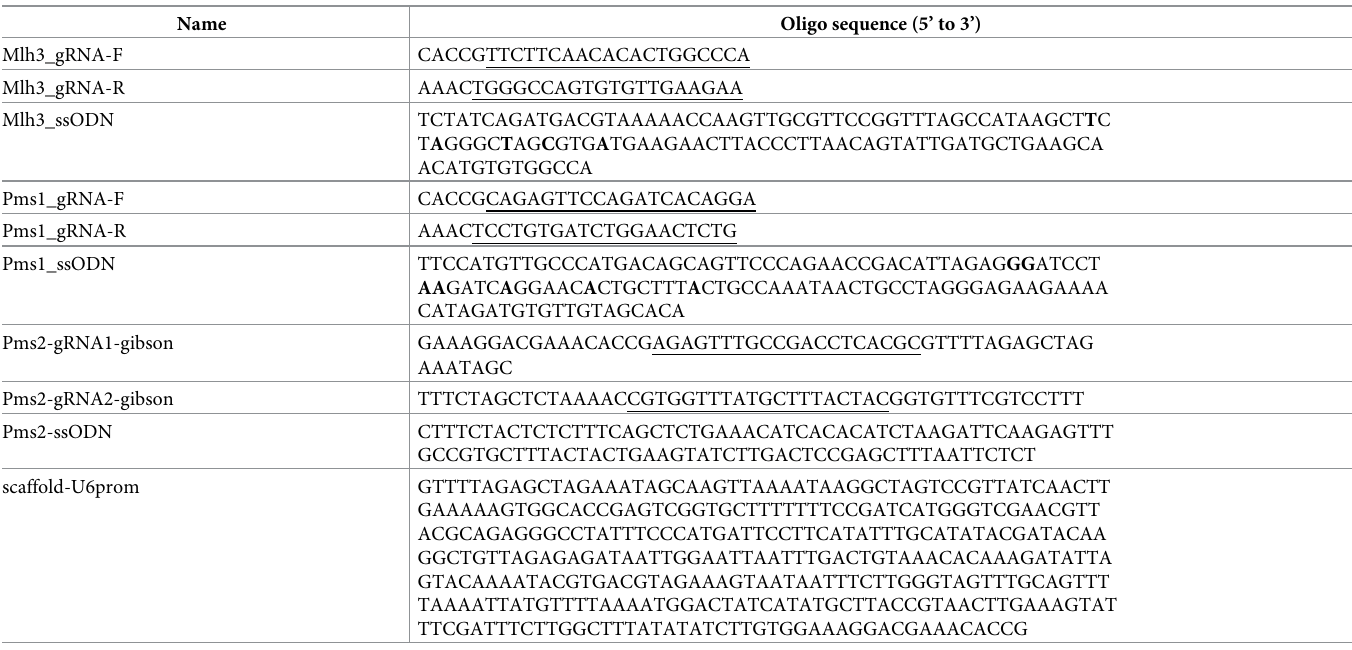
Table 2. Oligonucleotides used to generate the Mlh3 -/- , Pms 1 -/- and Pms 2 -/- mESCs.